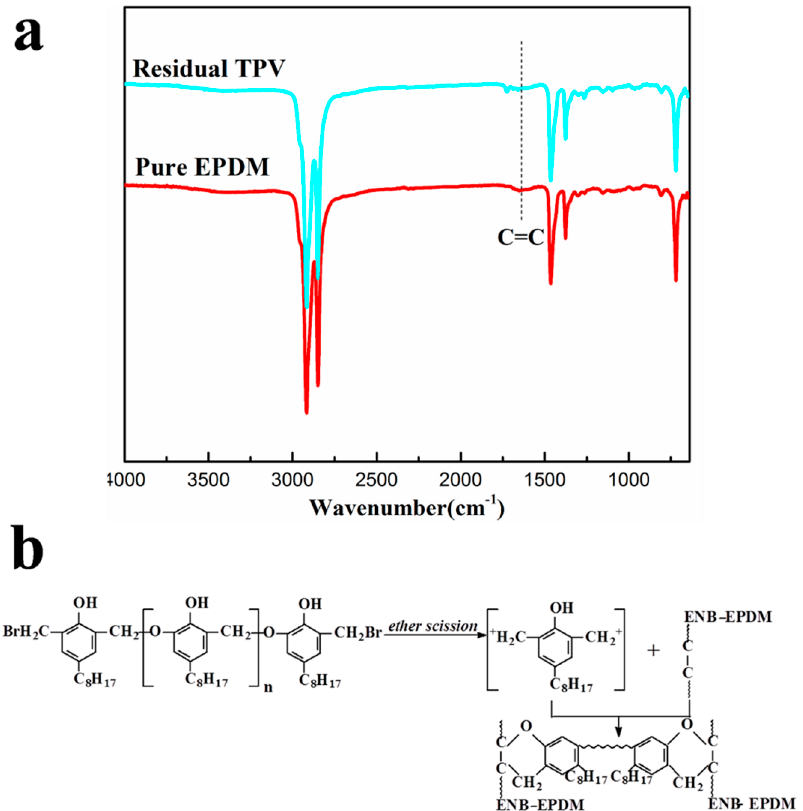
Figure 3. ( a ) FTIR spectra of ethylene-propylene-diene rubber (EPDM) and residual TPV sample after extraction using xylene steam in a Soxhlet extractor; ( b ) a possible schematic drawing of the reactions of PF and EPDM.